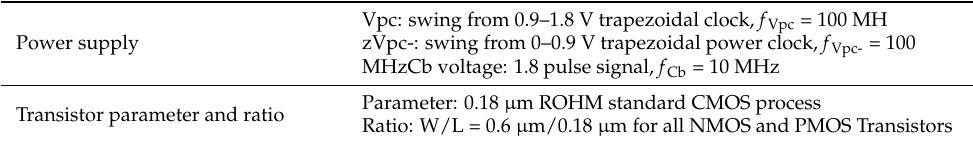
Table 1. Simulation